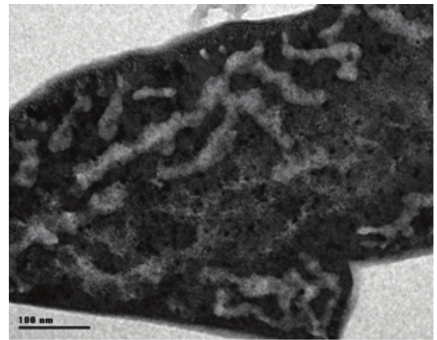
Figure 8: TEM image of activated carbon from orange peel after adsorbing organic